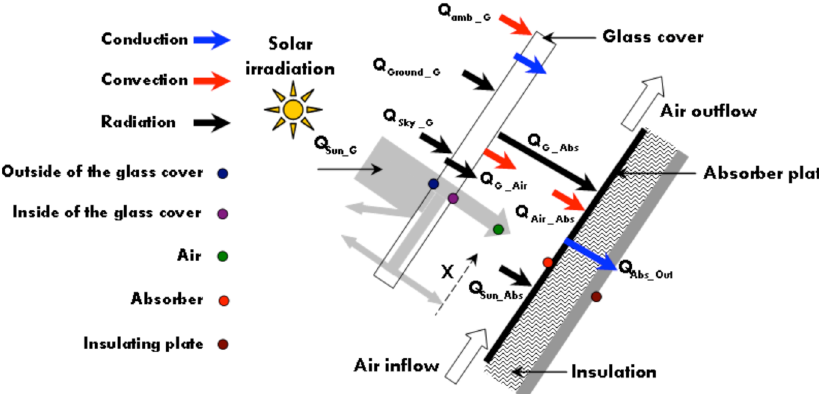
Fig. 1. Schematic view, types of nodes and heat balance of the fl at plate